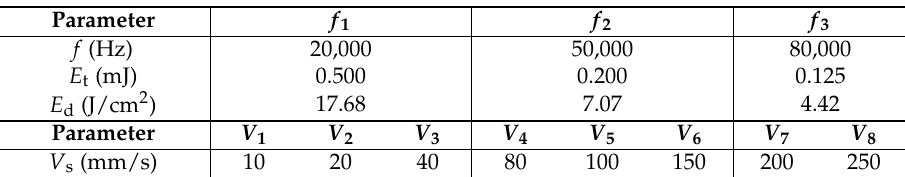
Table 1. Laser processing